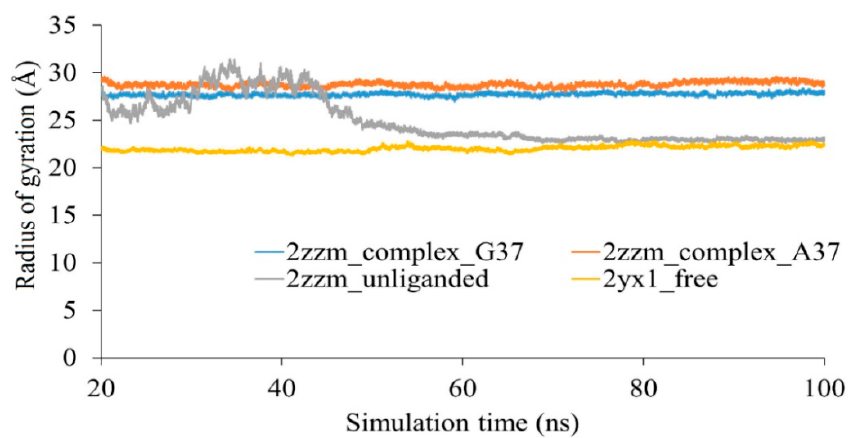
Figure 3. Radius of the gyration of wild-type complex (2zzm_complex_G37), complex with G37A tRNA mutation (2zzm_complex_A37), unliganded complex protein (2zzm_unliganded), and free protein (2yx1_free).